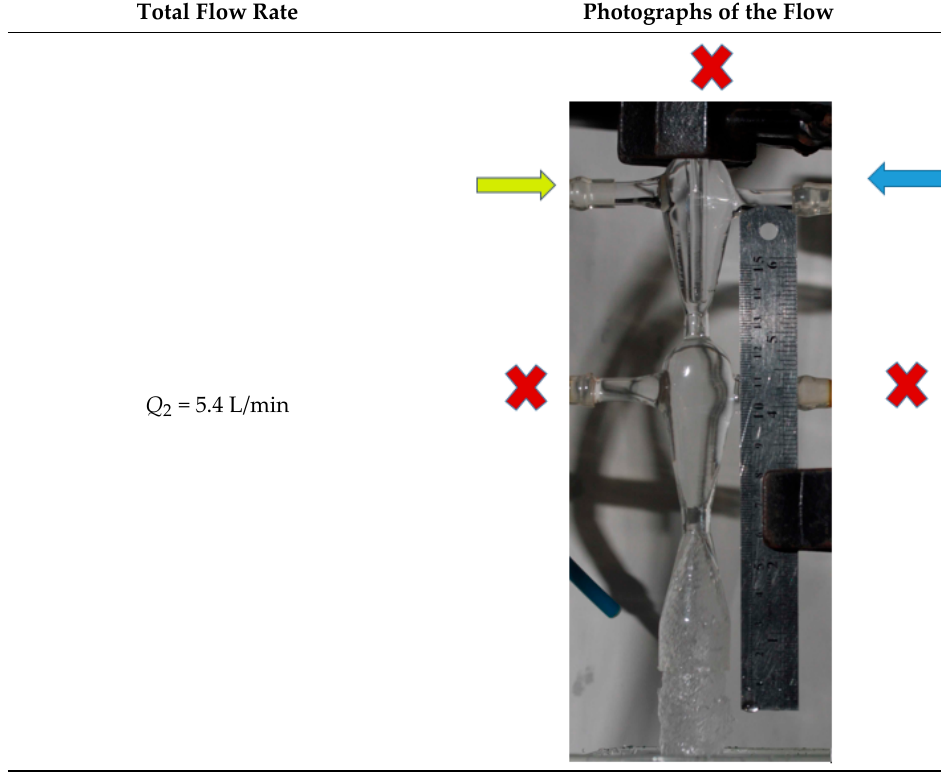
Table A1. Cont. Total Flow Rate Photographs of the